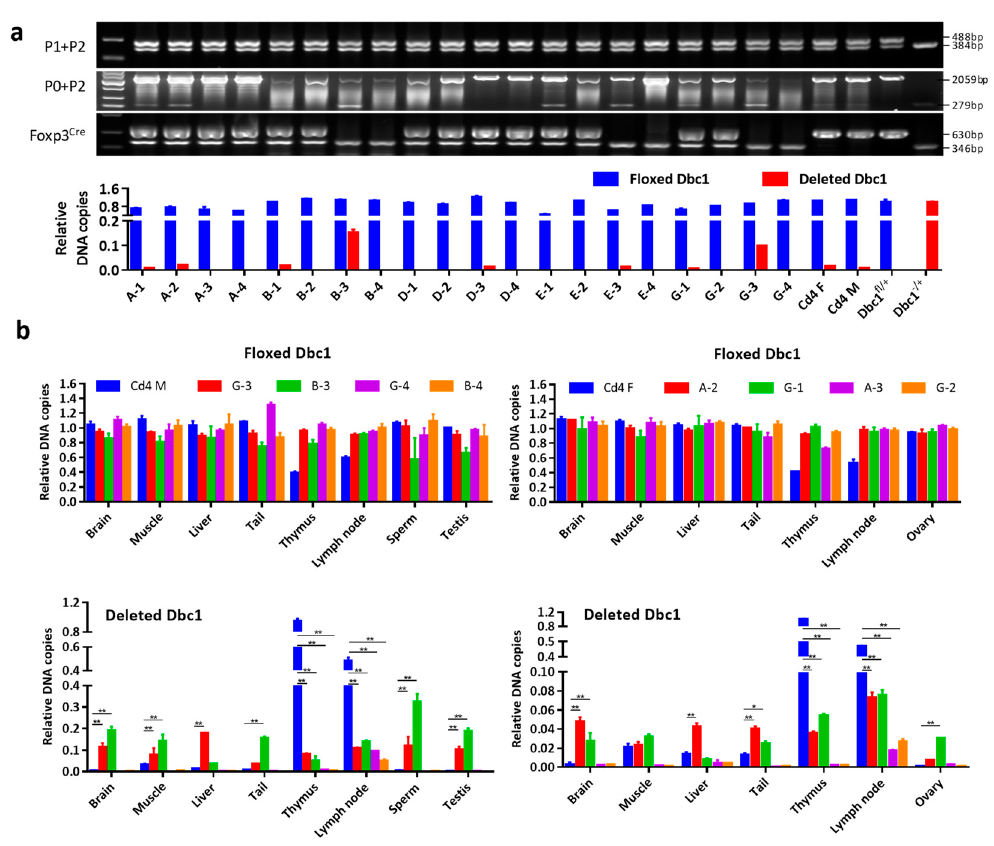
Figure 4. The floxed Dbc1 allele was recombined in non-T cells of some Foxp3 Cre Dbc1 fl mice. ( a ) The relative amount of floxed Dbc1 and the recombined Dbc1 of the mice in the progeny of different breeding pairs. The results were compared to the Cd4 Cre/+ Dbc1 fl/+ mice. For qPCR, the results were normalized to the DNA sample from Dbc1 fl/+ mice or mouse #4 in Figure 2a. Mouse #A-1, A-2, A-3, A-4 are offspring of Wt × Foxp3 Cre/Y Dbc1 fl/fl mice. Mouse #B-1, B-2, B-3, B-4 are offspring of Foxp3 Cre/Cre Dbc1 fl/fl × Wt mice. Mouse #D-1, D-2, D-3, D-4 are offspring of Wt × Foxp3 Cre/Y Dbc1 fl/+ mice. Mouse #E-1, E-2, E-3, E-4 are offspring of Foxp3 Cre/+ Dbc1 fl/+ × Wt mice. Mouse #G-1, G-2, G-3, G-4 are offspring of Foxp3 Cre/+ × Dbc1 fl/+ mice. The data were represented as the mean ± standard deviation of three independent experiments. The panel of Foxp3 Cre shows the genotype of Foxp3 -IRES-YFP-Cre alleles. ( b ) The relative amount of the floxed Dbc1 and recombined Dbc1 of the indicated tissue of the mice in ( a ) was tested by qPCR. For qPCR, the results were normalized to the DNA sample from Dbc1 fl/+ mice or mouse #4 in Figure 2a. The data were represented as the mean ± standard deviation of three independent experiments. “Cd4 F” means female Cd4 Cre/+ Dbc1 fl/+ mouse while “Cd4 M” means male Cd4 Cre/+ Dbc1 fl/+ mouse. * p < 0.05; ** p < 0.01.